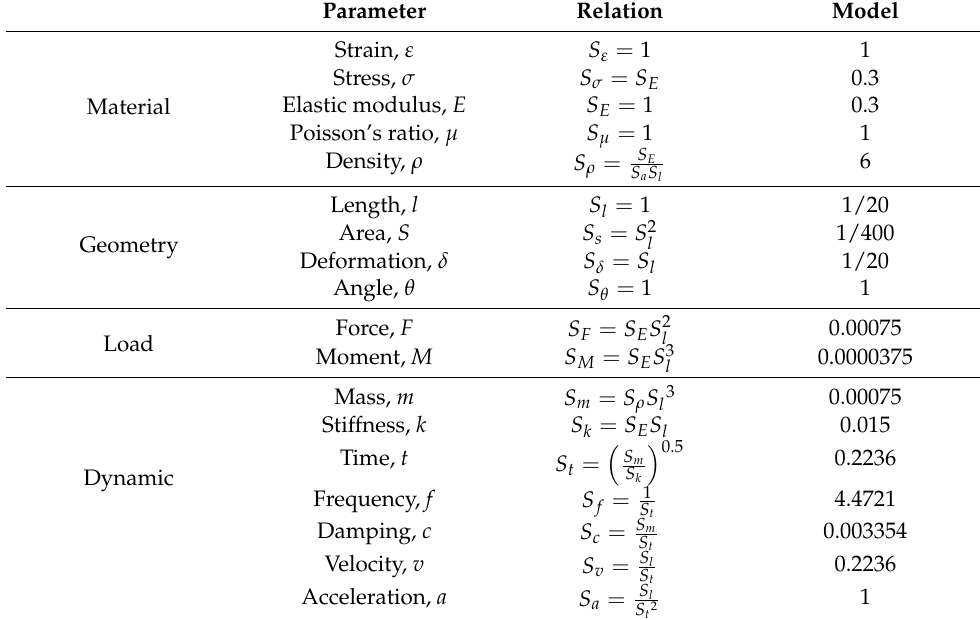
Figure 11. Bridge model (unit: mm). Table 1. Design similitudes of cable-stayed bridge model.